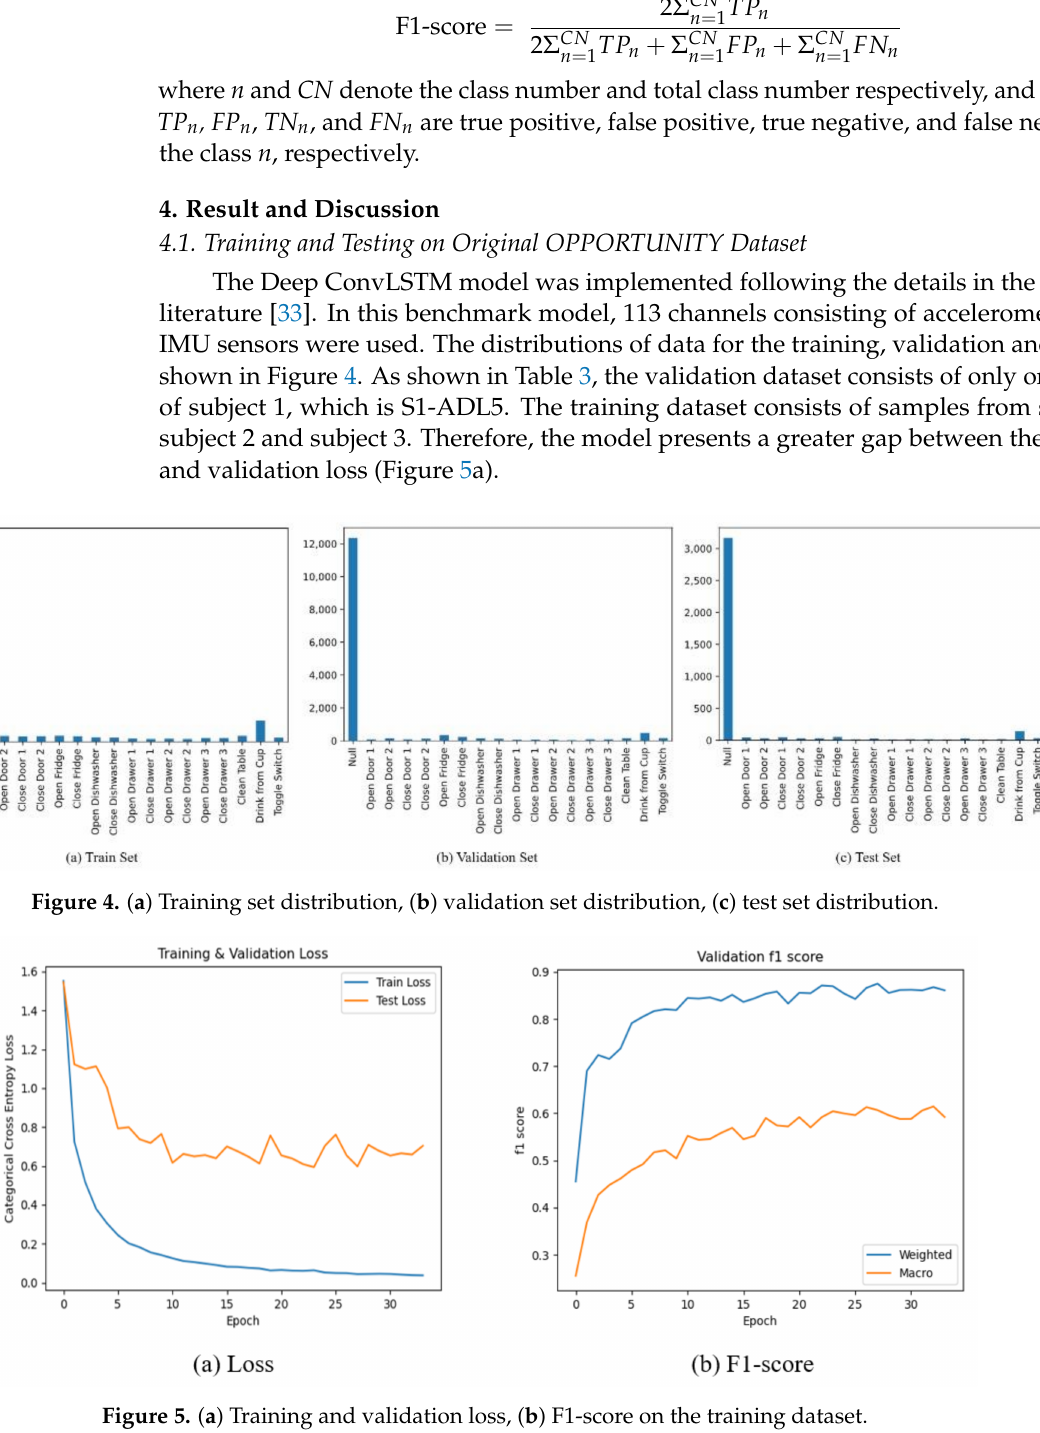
Figure 5. ( a ) Training and validation loss, ( b ) F1-score on the training